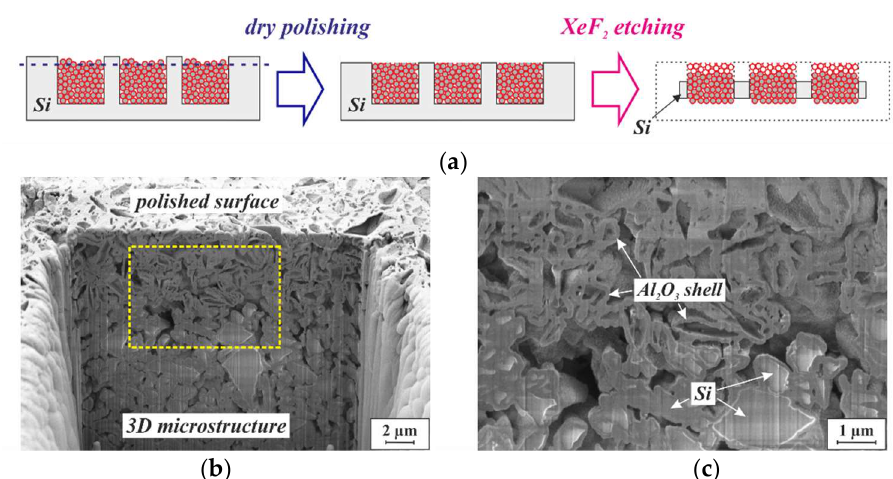
Figure 9. ( a ) Schematic illustration of the procedure applied to investigate the contact points be- tween neighboring particles. ( b ) SEM micrograph of an FIB cut through a 3D microstructure that has been agglomerated from Si particles with 1 µm mean size by 75 nm ALD-Al 2 O 3 . After dry-polishing at the wafer level and dicing into chips, the 3D microstructure was exposed to isotropic etching in XeF 2 vapor. ( c ) Micrograph of the area within the dashed yellow frame in ( b ).